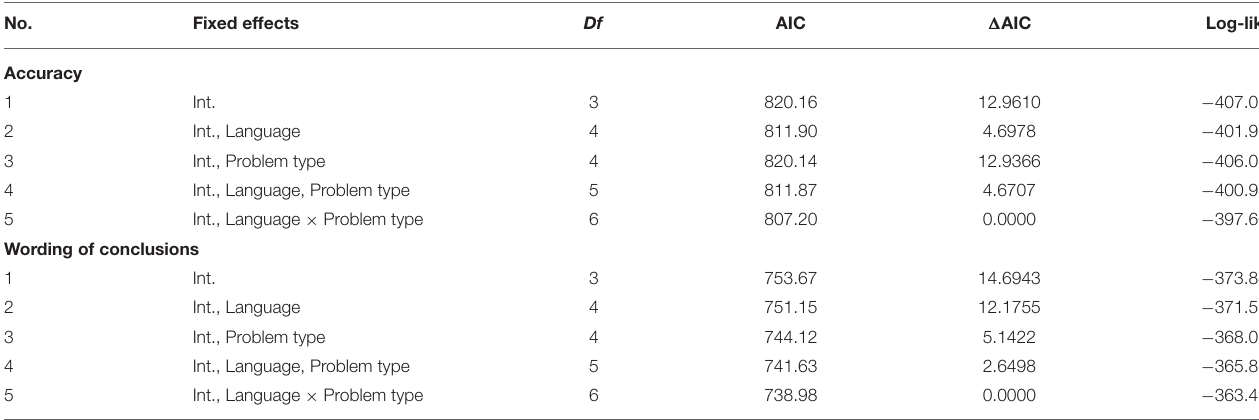
TABLE 2 | Models testing sequence for Accuracy and Wording of conclusions.